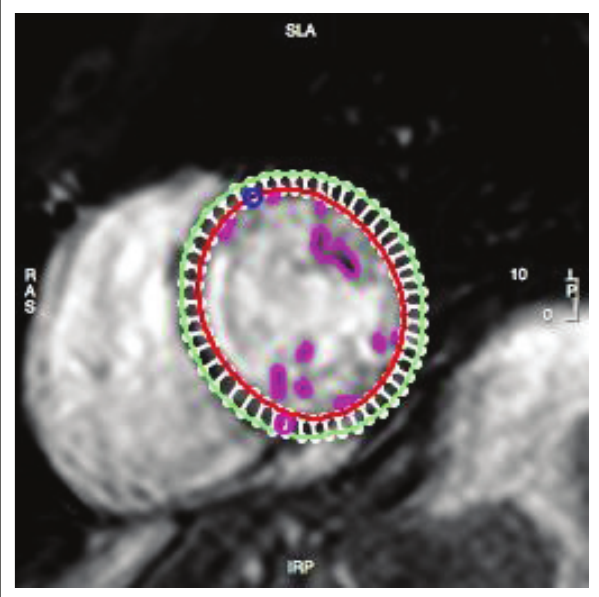
FIGURE 1: Short-axis views were utilised to perform the functional analysis with dedicated software.